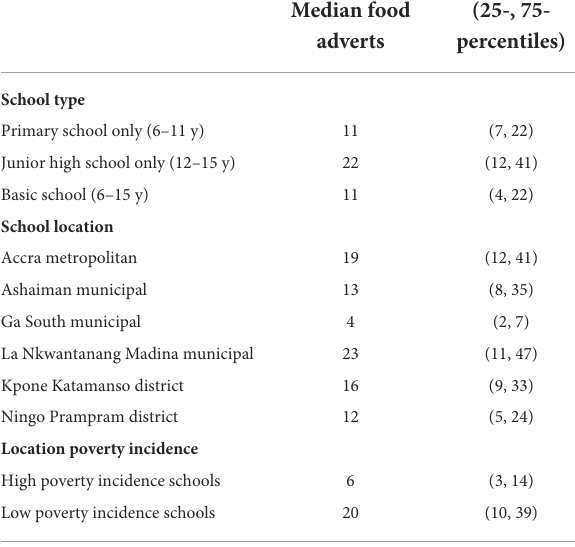
TABLE 1 Median number of food and beverage advertisements along a 250m road network around schools by school type and location